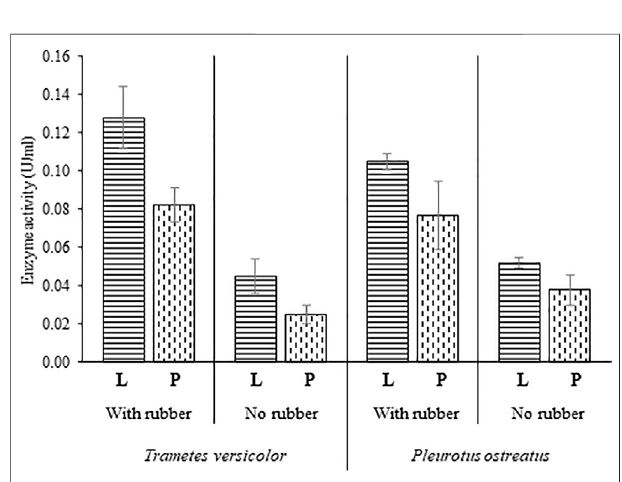
FIGURE 4 | Laccase and peroxidase activity in cultures of Trametes versicolor and Pleurotus ostreatus in the presence and the absence of vulcanized rubber particles. L, laccasse, P, peroxidase. Measurements were carried out in triplicates.